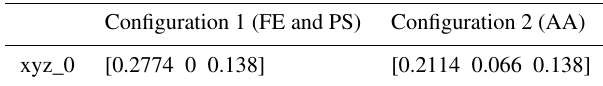
Table 2. Positions of the wrist joint